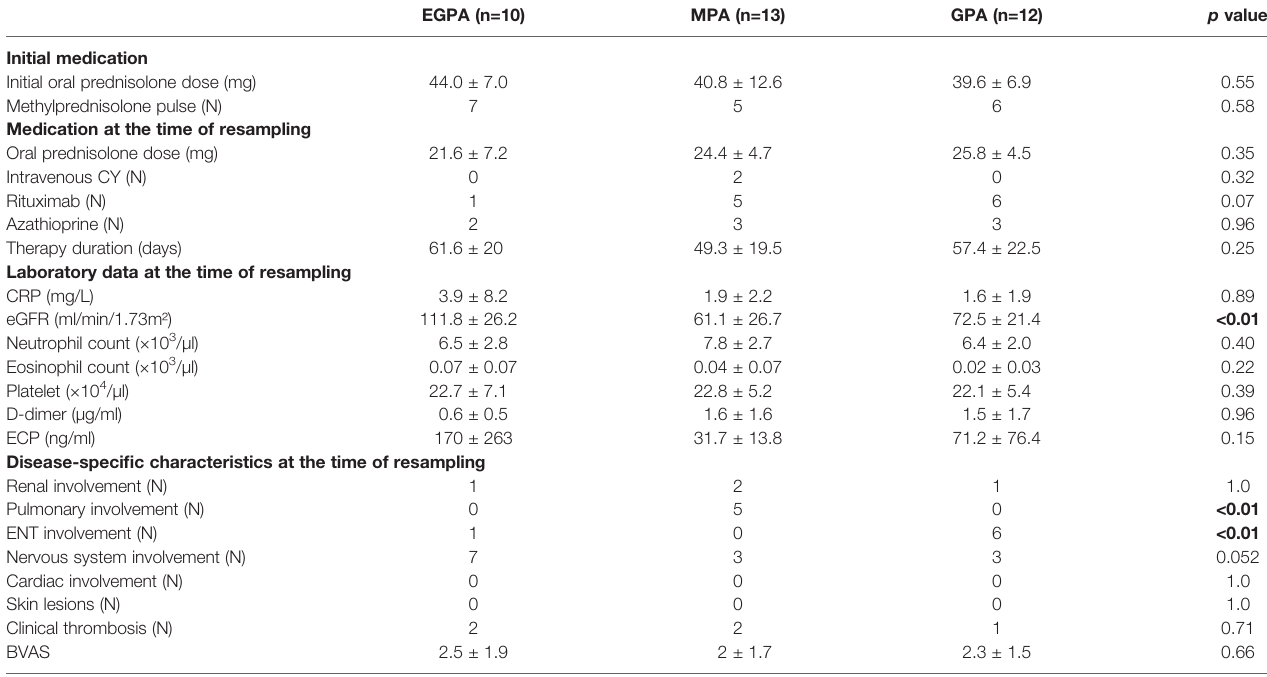
TABLE 2 | Patient characteristics after the initiation of immunosuppressive